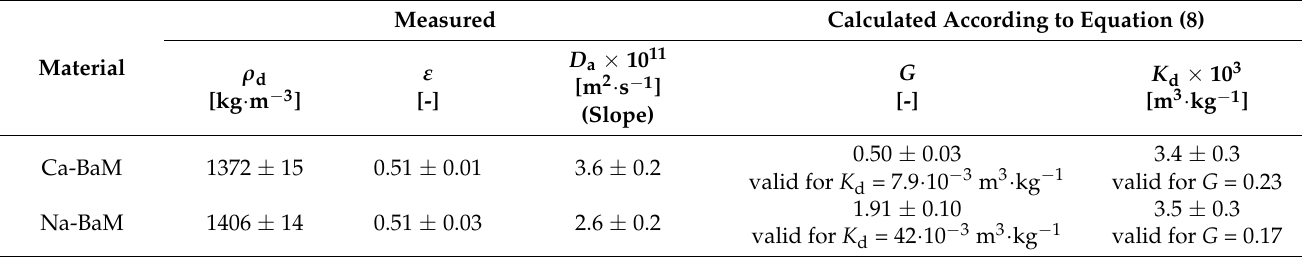
Figure 5. Profiles of Sr total concentration in the compacted Ca- and Na-bentonite after 1, 3 and 5 days of contact shown as dependences of C tot on x ( left ) and ln C tot on x 2 / t ( right ). C 0 (Sr) was 10 mol · m − 3 , V 0 was 7.5 × 10 − 8 m 3 . AS refers to the analytical solution of diffusion equation fitted to the experimental data using the ‘slope’ method, fitted apparent diffusion coefficients are summarized in Table 4. Table 4. Mean experimental and calculated values of Sr diffusion